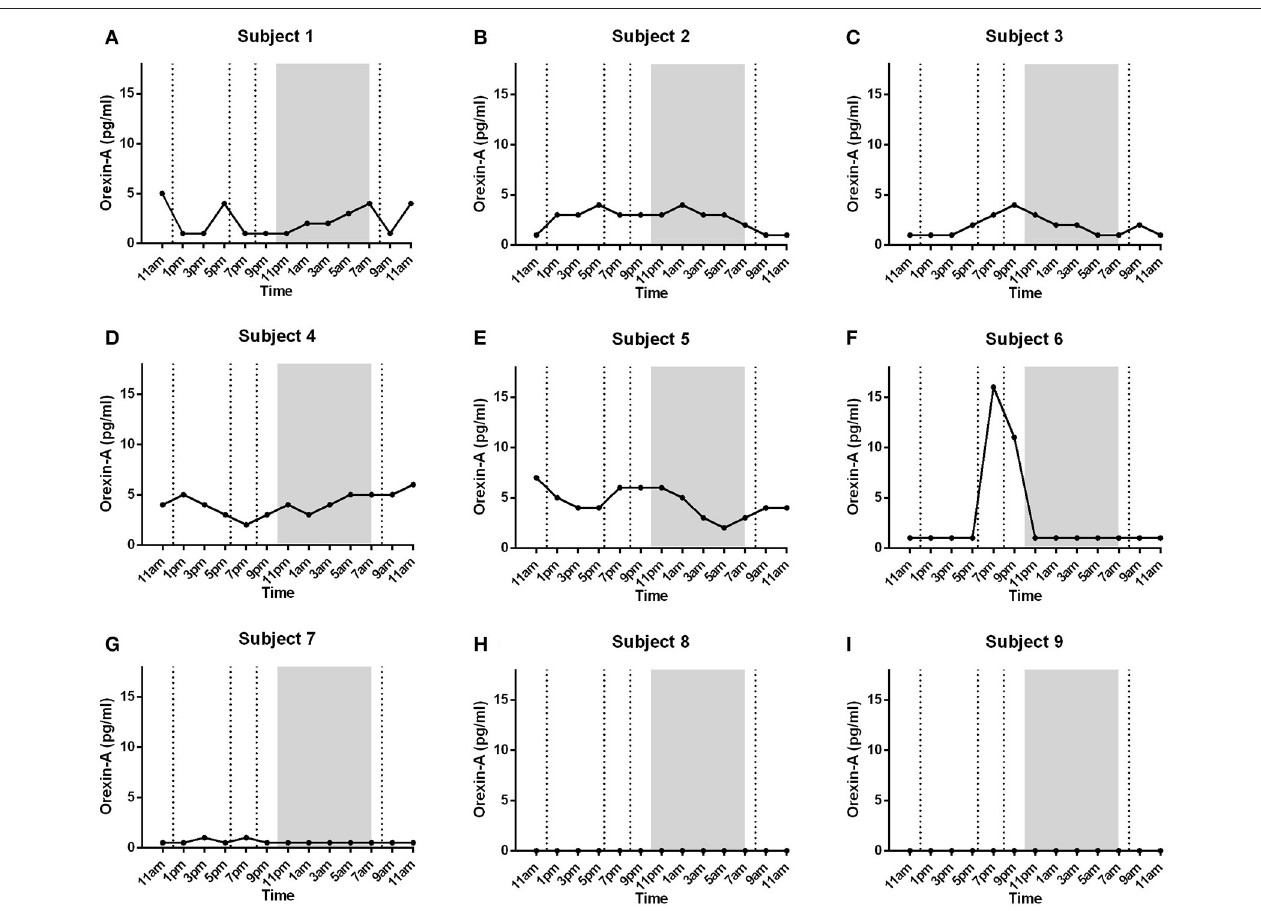
FIGURE 2 | Individual data of plasma OXA levels in nine healthy male subjects ( (A-G) and (H,I) were added to the text): Lunch, dinner, evening snack and breakfast are marked with dotted lines in respective order. Night-time (lights off) is marked with shaded region. Plasma concentrations varied from 0.5 – 16 pg/ml within 7 subjects (A-G) with no association to eating, wake or sleep between different subjects. In 2 subjects (H,I) plasma OXA levels were undetectable (below 0.5 pg/ml).